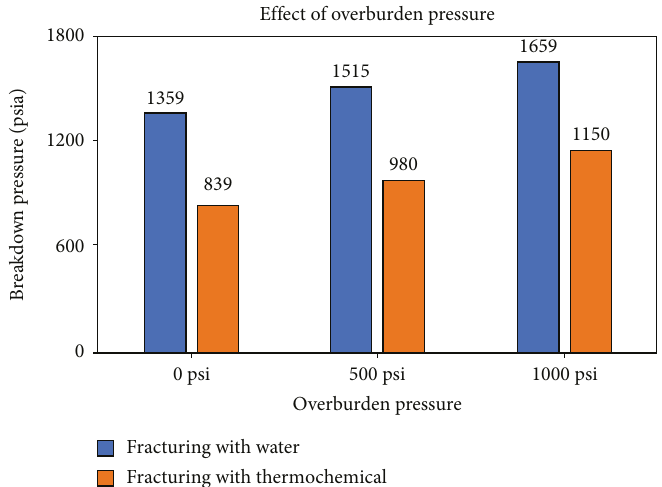
Figure 17: Comparison of e ff ect of overburden pressure on breakdown pressure obtained from fracturing with water and